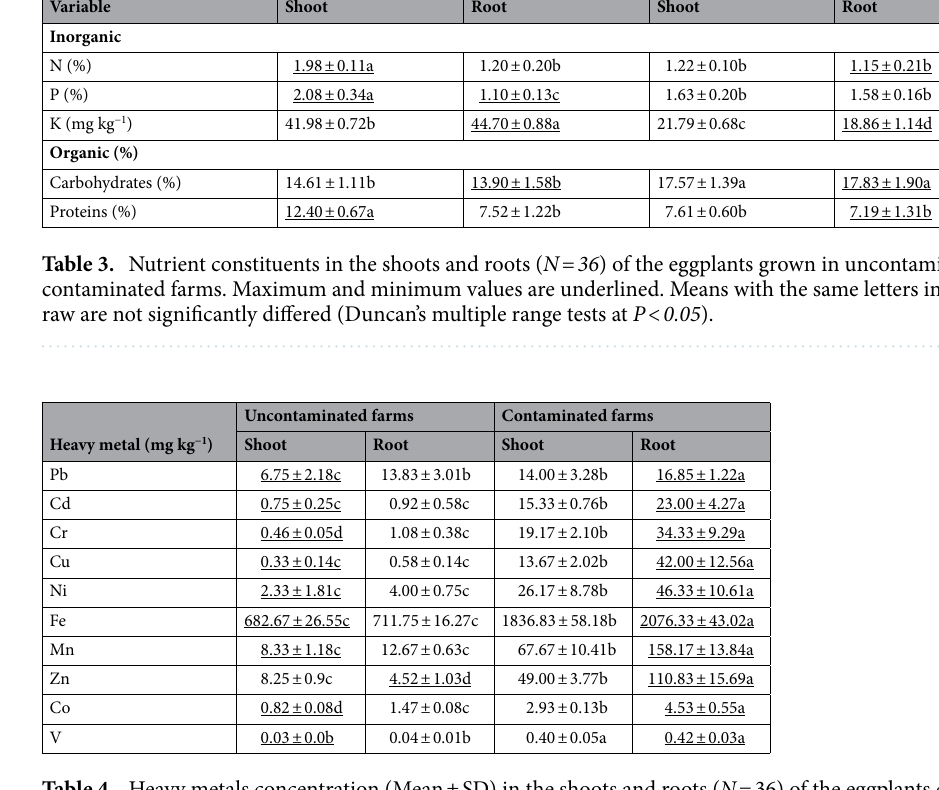
Table 4. Heavy metals concentration (Mean ± SD) in the shoots and roots ( N = 36) of the eggplants cultivated in uncontaminated and contaminated farms. Maximum and minimum values are underlined. Means with the same letter in the same raw is not significantly differed (Duncan’s multiple range tests at P < 0.05